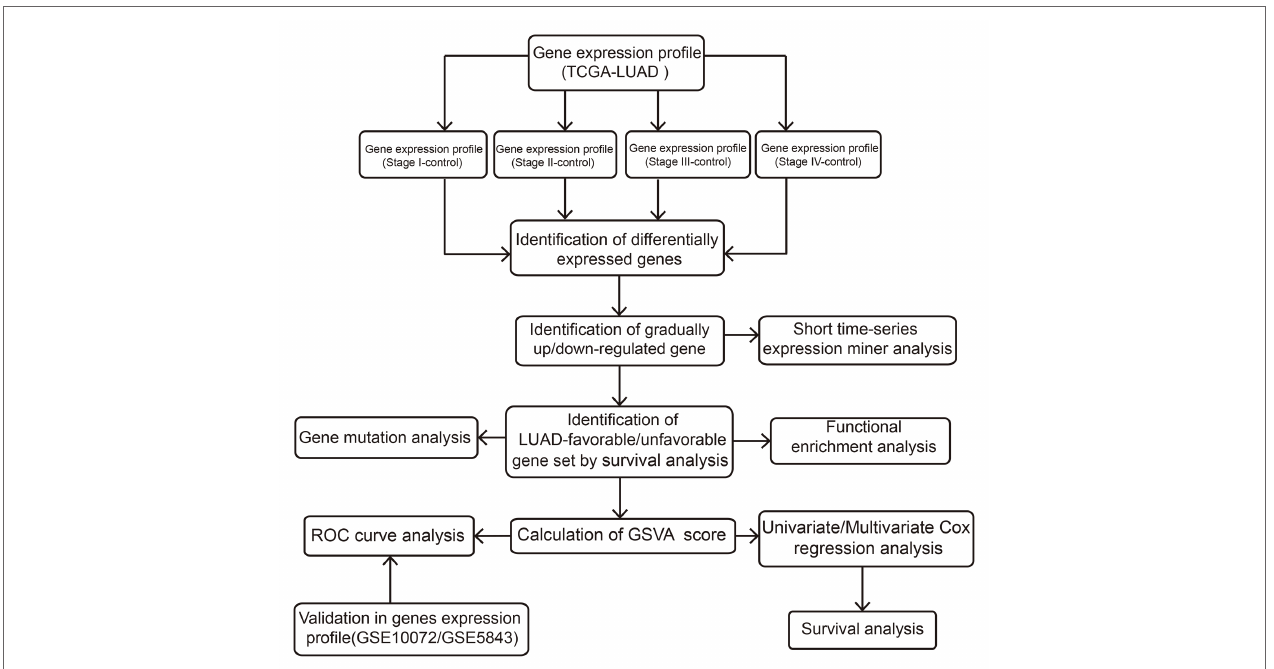
FIGURE 1 | Flowchart of this